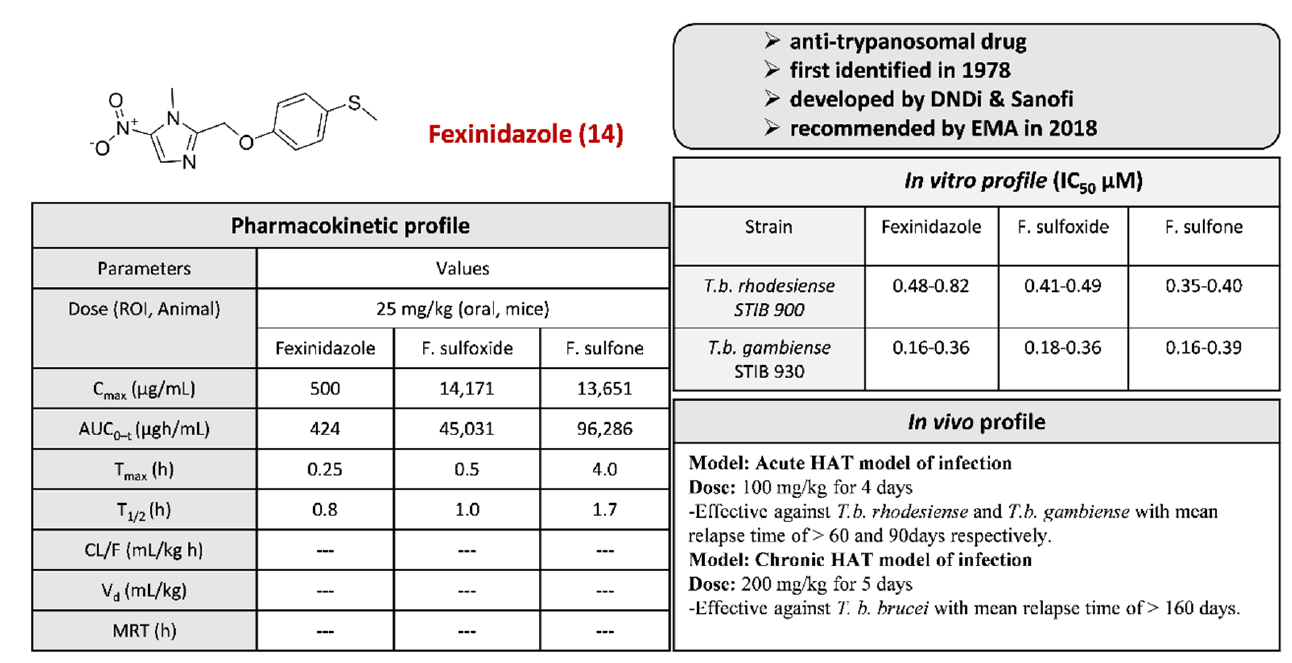
Figure 18. Activity profile of Fexinidazole 14 . [10]